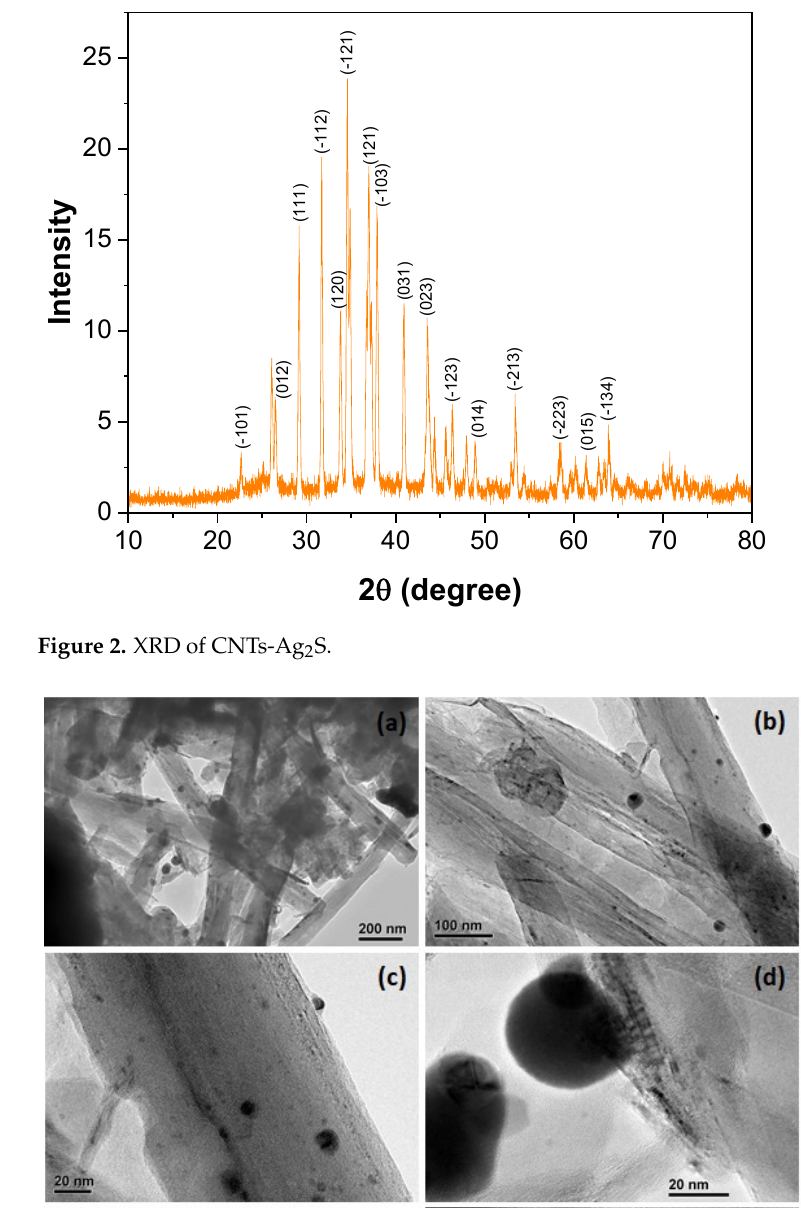
Figure 1. ATR ‐ FTIR spectra of ( a ) CNTs ‐ COOH, ( b ) Ag 2 S, and ( c ) CNTs ‐ Ag 2 S.